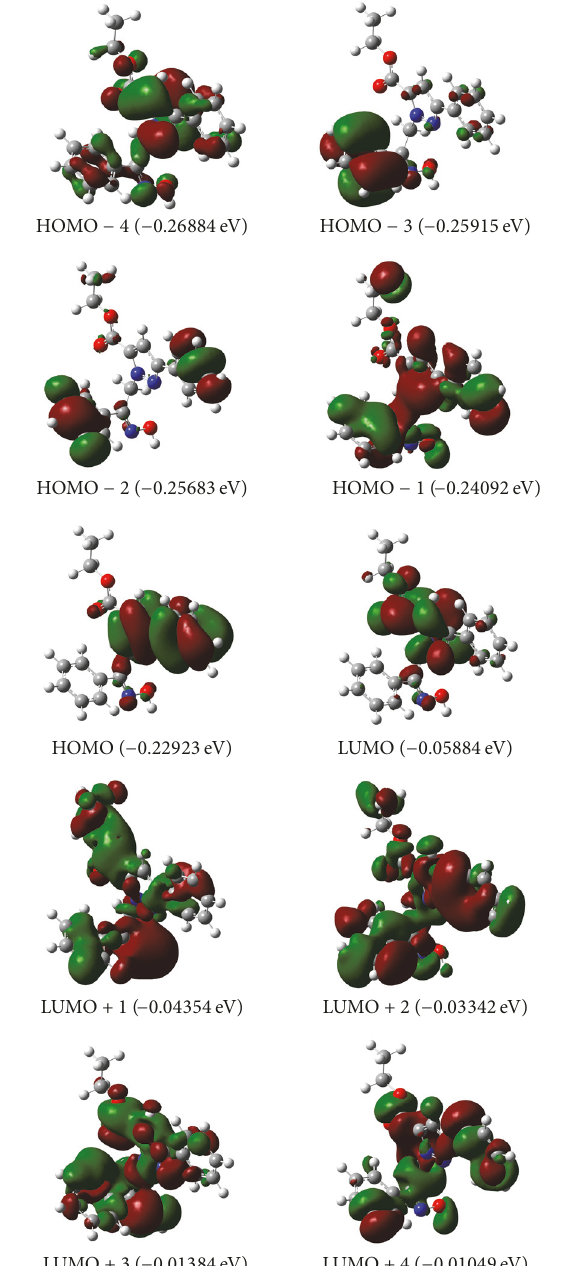
Figure 6: Representative frontier molecular orbital plots of